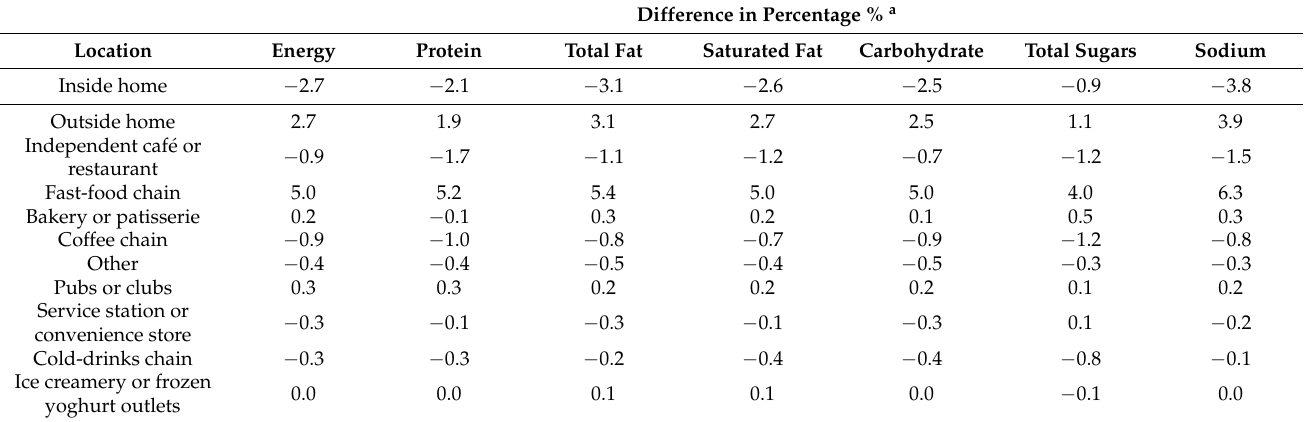
Table 2. Differences by gender (males, females) in the mean daily proportion of energy and nutrients contributed by foods prepared inside and outside of home and by different food outlet categories ( n = 435 males and n = 556